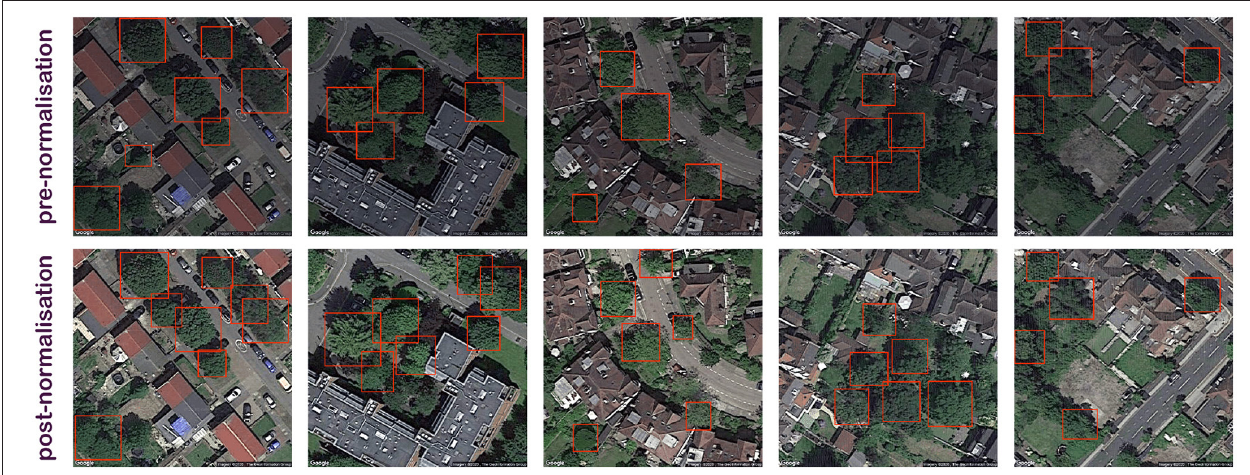
FIGURE 1 | The impact of brightness, saturation, and normalization processes on tree detection performance. Normalized images are exhibiting a noticeably better detection accuracy.